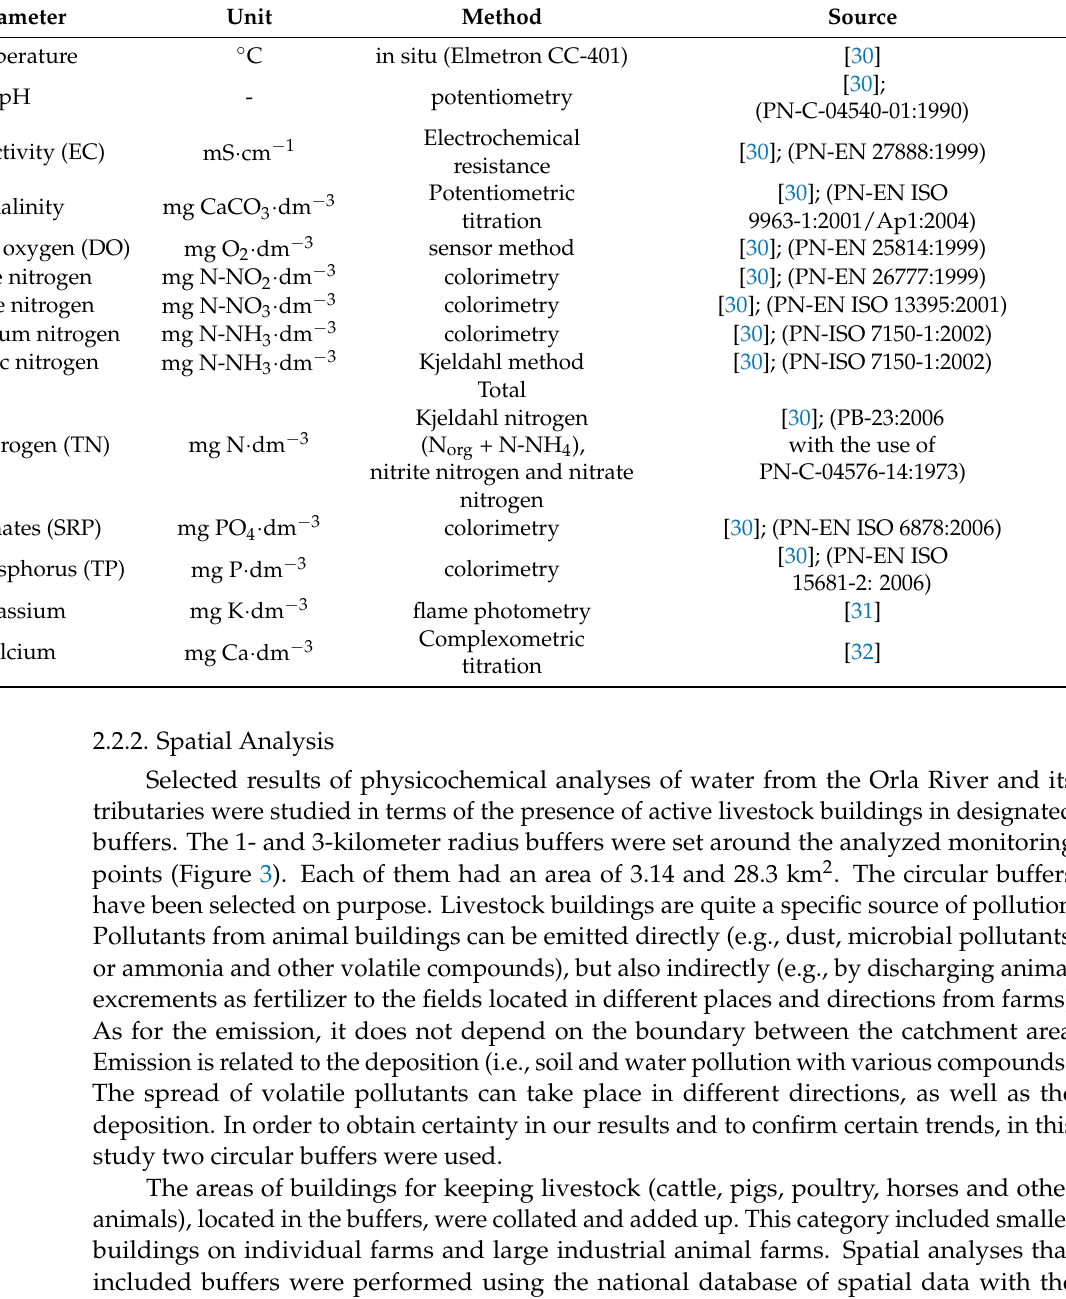
Table 2. Summary of methods used to determine individual chemical